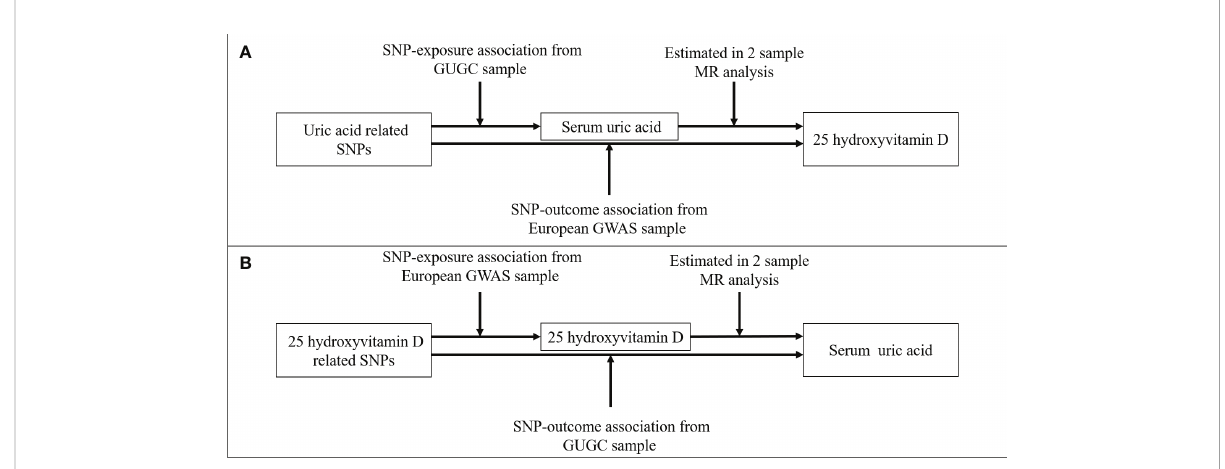
FIGURE 1 Two-sample bidirectional Mendelian Randomization study of the association of serum uric acid and 25-hydroxyvitamin D. (A) Data sources for investigating the causal association of serum uric acid on 25-hydroxyvitamin D. (B) Data sources for investigating the causal association of 25- hydroxyvitamin D on serum uric